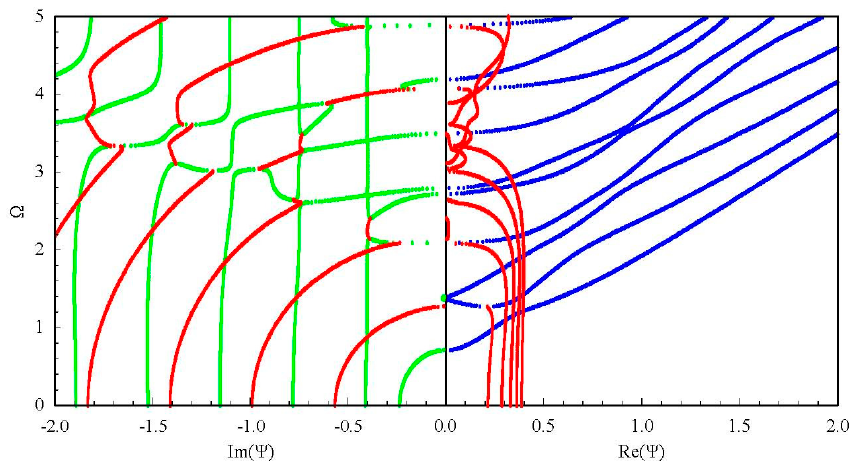
Figure 10. Frequency spectrum of a Lamb-like wave for mechanical fixed boundary and electricity closed-circuit boundary conditions.